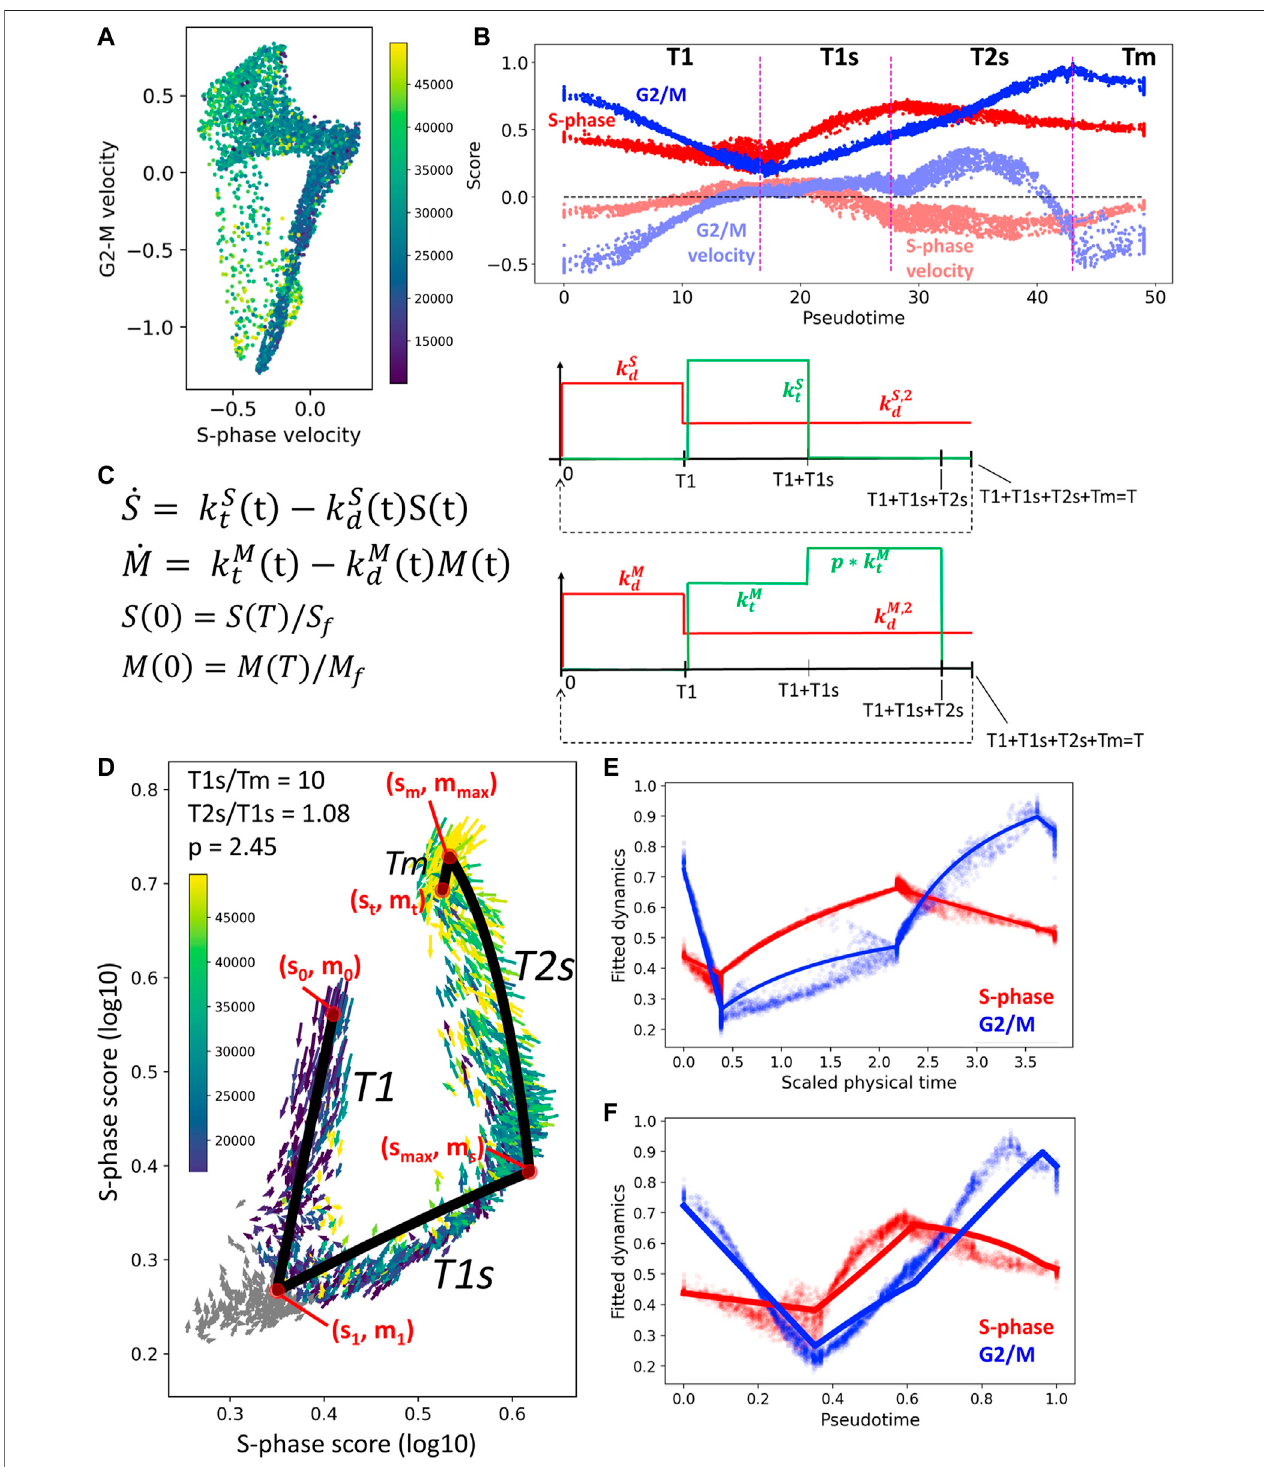
FIGURE6| Simplekineticmodelofcellcycletranscriptomedynamics. (A) MeanRNAvelocityvaluesforS-phaseandG2/Mgenes. (B) Pseudotemporal dynamics of S-phase and G2/M scores (shown with more intense color) and mean RNA velocity values (shown with semi-transparent color). (C) Description of the simple kinetic model of cell cycle transcriptome. Model equations are shown on the left and the changes in the values of kinetic rates (degradation, in red, and synthesis, in green). (D) Resultof fi ttingthemodeldynamicstocellcycletranscriptomedynamicsobservedinCHLA9cellline. (E,F) Inferredphysicaltimeandpseudotemporaldynamicsof cell cycle transcriptome in CHLA9 cell